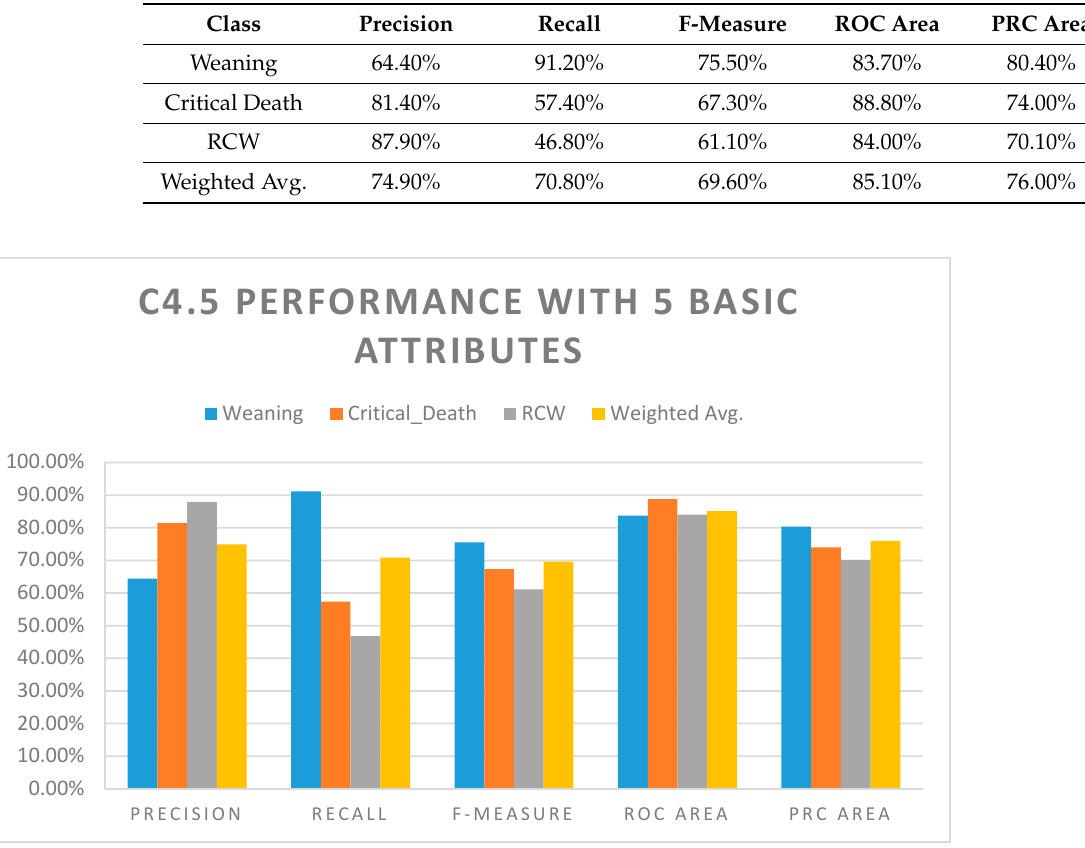
Figure 1. C4.5 algorithm performance with five basic attributes.